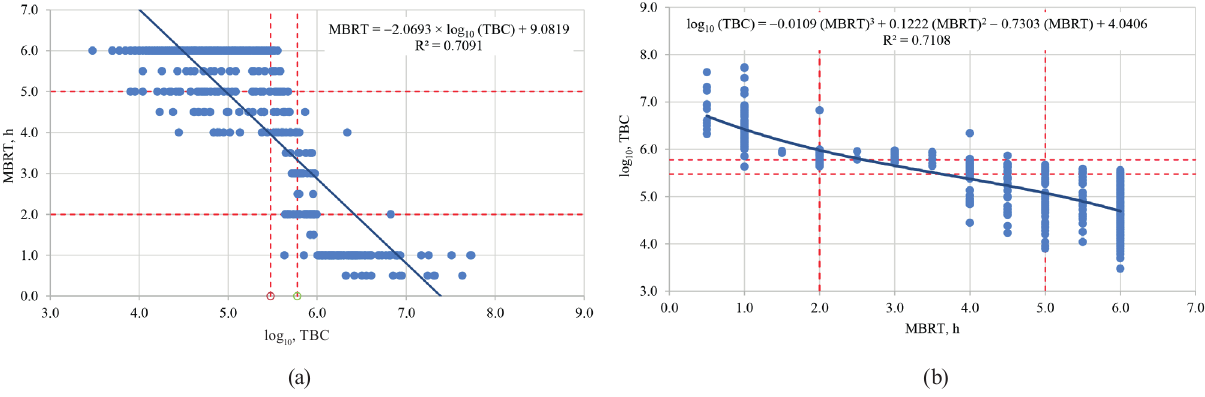
Figure 4 Correlation between (a) MBRT vs log that delimit milk quality